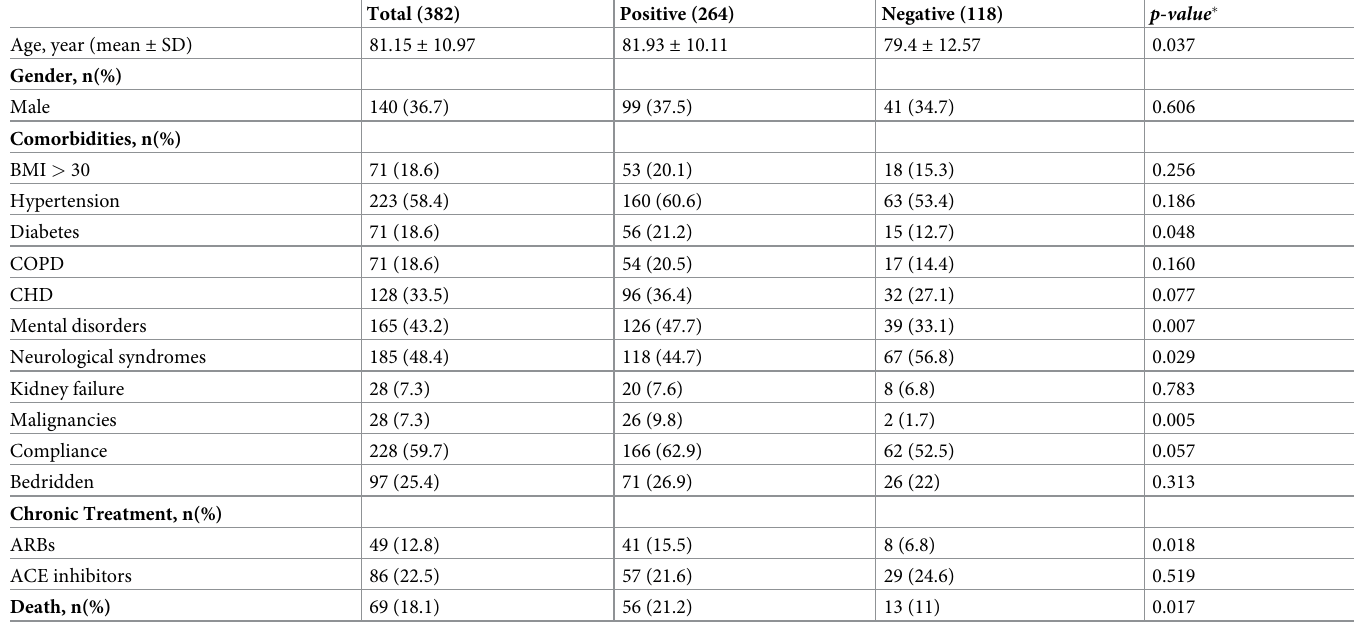
Table 1. Comparison of characteristics of 382 people living in retirement nursing homes, divided into people with (264) and without (118) SARS-CoV-2 infection.